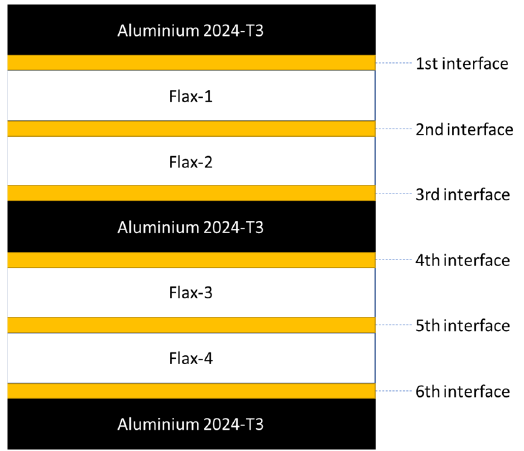
Figure 9. Schematic of interfaces between layers of the NFML.